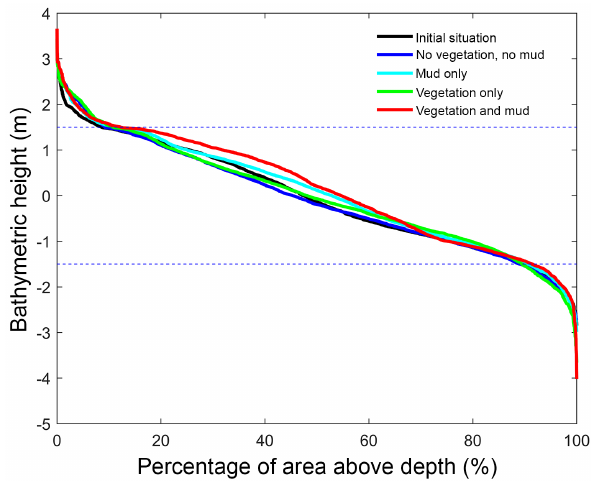
Figure 5. Hypsometry of the entire estuary after 100 years. Dashed lines indicate the tidal range at the seaward boundary. Around 70% of the estuary area is intertidal in all scenarios, indicating that the model represents a shallow system. The hypsometry is determined over the surface occupied by the estuary of the initial condition, which excludes new areas formed by bank erosion that is modelled rather simplistically in